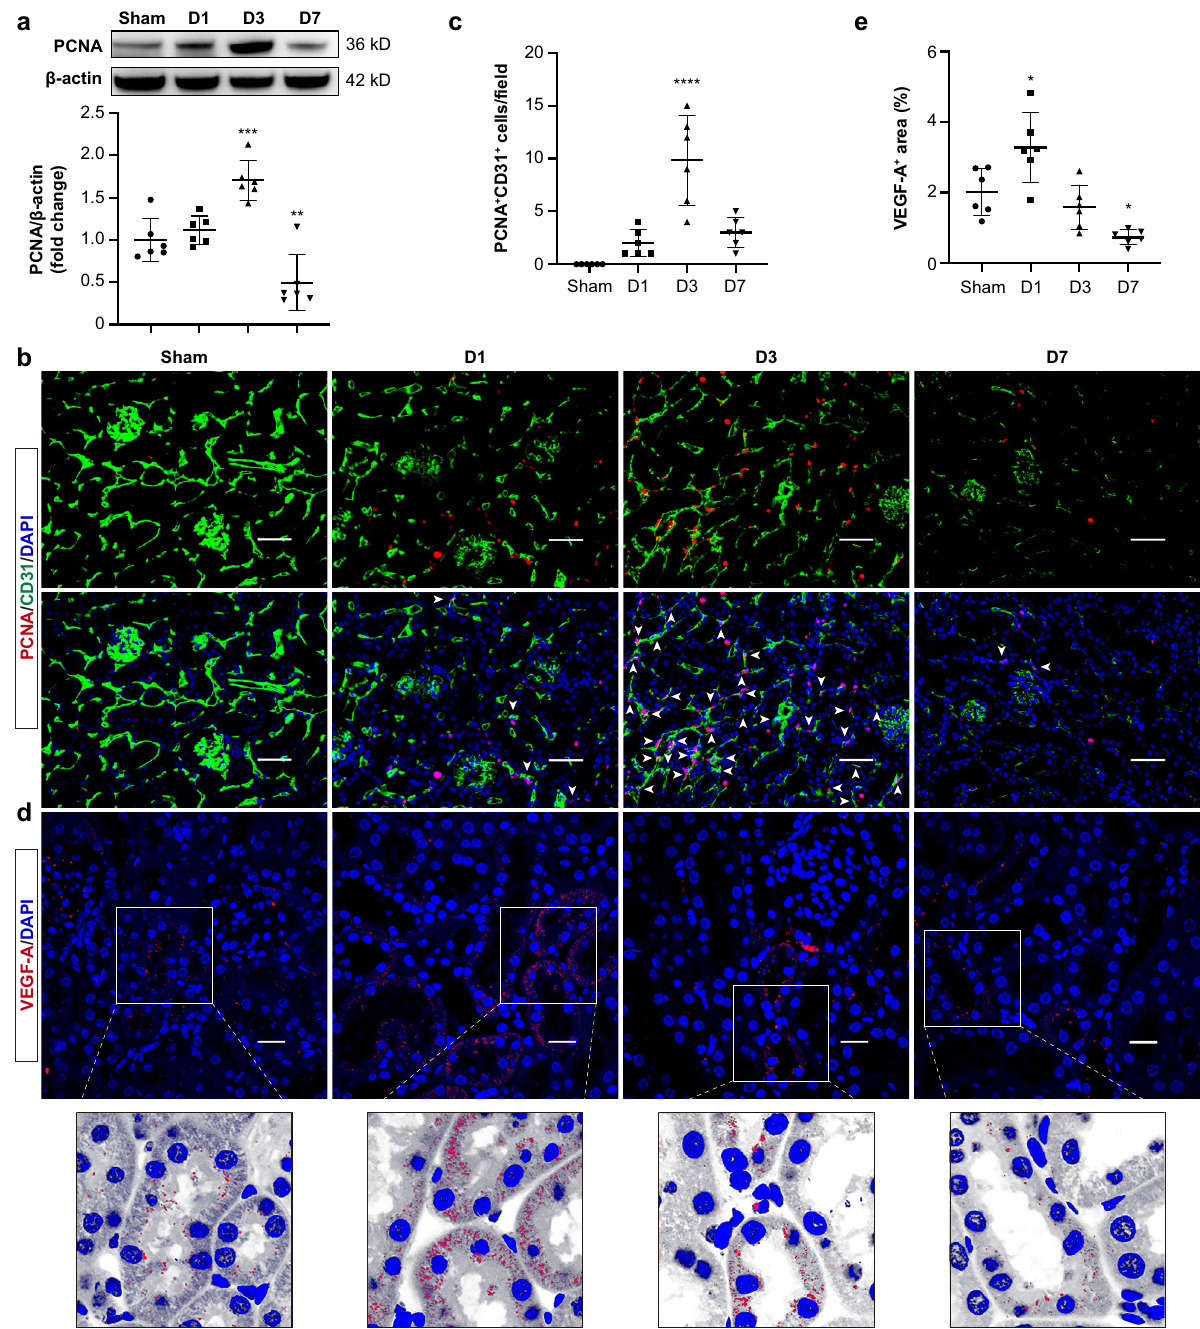
Fig. 2 PTCs proliferation and tubular expression of VEGF-A are induced after I/R injury. a Western blotting analysis of PCNA in kidneys ( n = 6). b Representative images of CD31- and PCNA-stained kidney sections. Scale bars, 100 μ m ( n = 6). c Quanti fi cation of PCNA + CD31 + cells (white arrowheads) on the basis of six mice, with at least 10 fi elds counted in each. d and e Representative confocal images of VEGF-A-stained kidney sections. Scale bars, 20 μ m. Quanti fi cation on the basis of six mice, with at least ten sections counted in each. Zoom panels show the redistribution of VEGF-A from the cytoplasm to the basolateral side of TECs. Data are presented as means ± SD. * p < 0.05, ** p < 0.01, *** p < 0.001, **** p < 0.0001 vs. Sham group. One-way